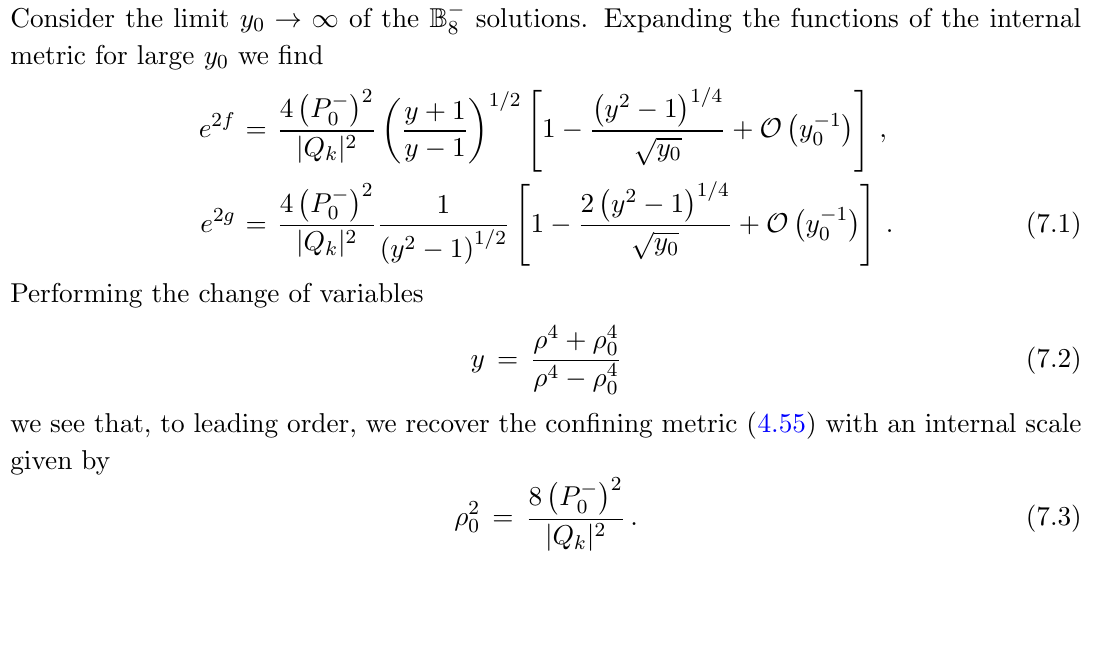
Figure 6 . Kretschmann scalar K = R (cid:22)(cid:23)(cid:26)(cid:27) R (cid:22)(cid:23)(cid:26)(cid:27) as a function of y for B + curves) with y 0 = (cid:0) 0 : 9 ; (cid:0) 0 : 3 ; 0 : 3 ; 0 : 9 from left to right, and for B (cid:0) with y 0 = 2 ; 3 ; 4 ; 5 from left to right. We see that at y = 1 all curves approach the same value since they all share the same UV asymptotics, whereas the curvature at the IR endpoint ( y = y 0 ) diverges as y 2 as y 0 ! 1 0